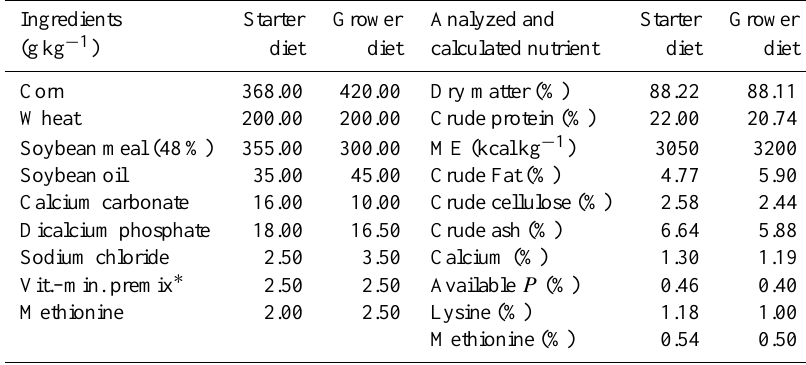
Table 1. Ingredient and chemical composition of starter and grower diets. Ingredients Starter Grower Analyzed and Starter Grower (gkg − 1 ) diet diet calculated nutrient diet Corn